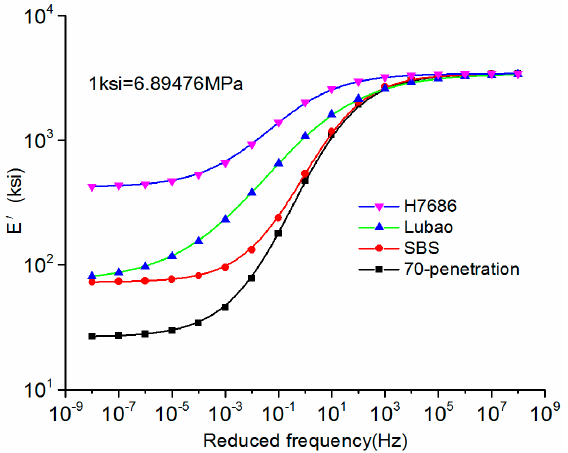
Figure 3. Master curves of the storage moduli at reference temperature 20 °C.